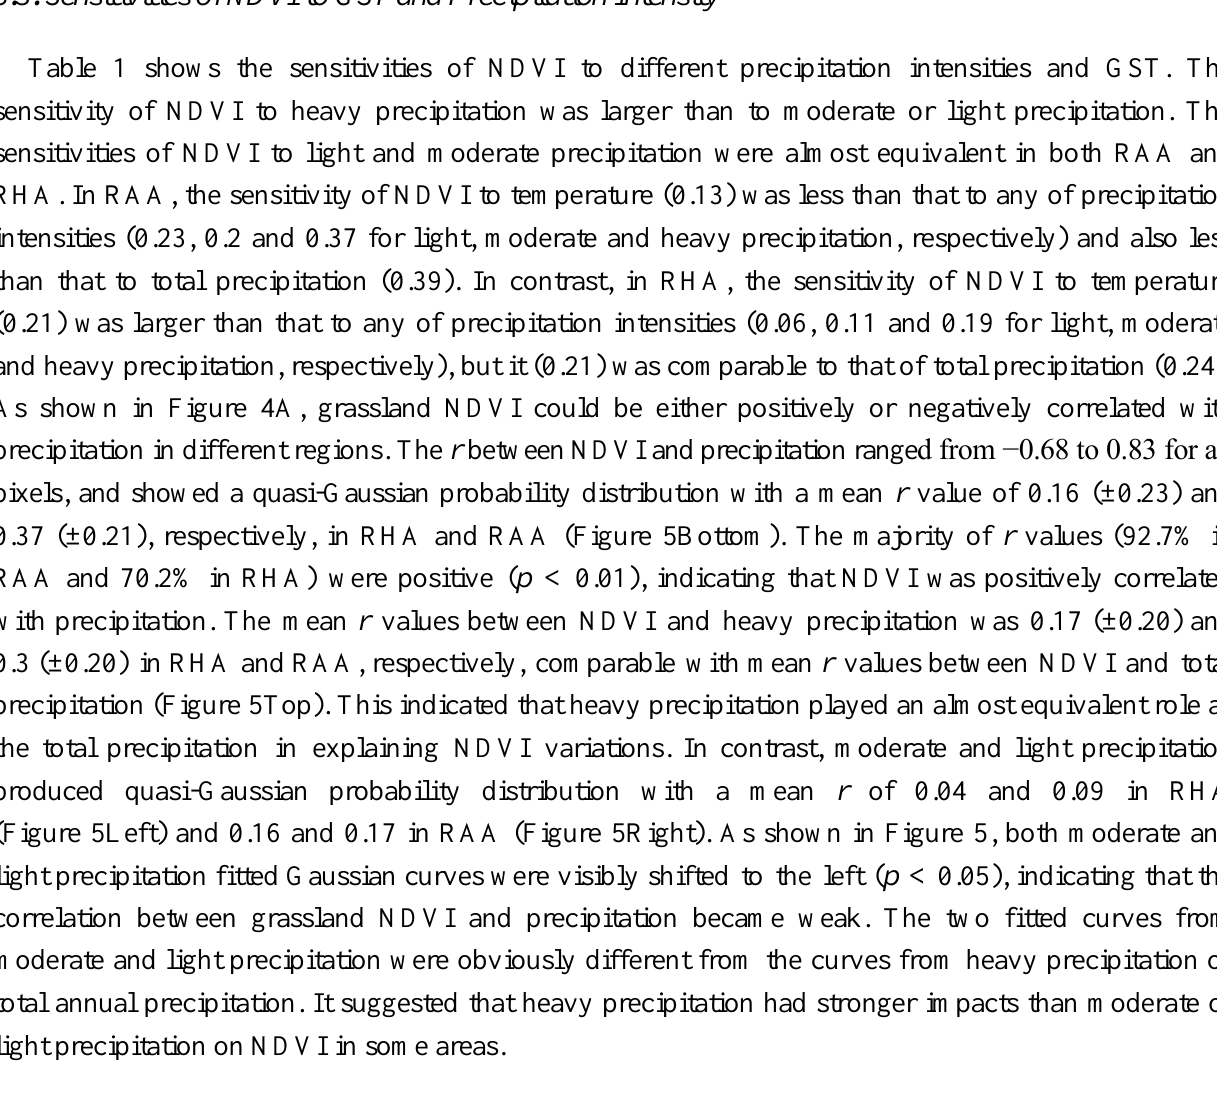
Table 1. Sensitivities (mean ± standard deviation) of normalized difference vegetation index (NDVI) to different intensity precipitation (heavy precipitation, a 1 ; moderate precipitation, a 2 ; light precipitation, a 3 ) and growing season temperature (GST) ( a 4 ), acquired by equation (2), and sensitivities of NDVI to total precipitation ( b 1 ) and GST ( b 2 ) acquired by equation (3) in relative humid areas (RHA) and relative arid areas (RAA), respectively. The p values were calculated pixel-by-pixel for each equation, and the percentage (Perc) of pixels of significance at p < 0.05 was